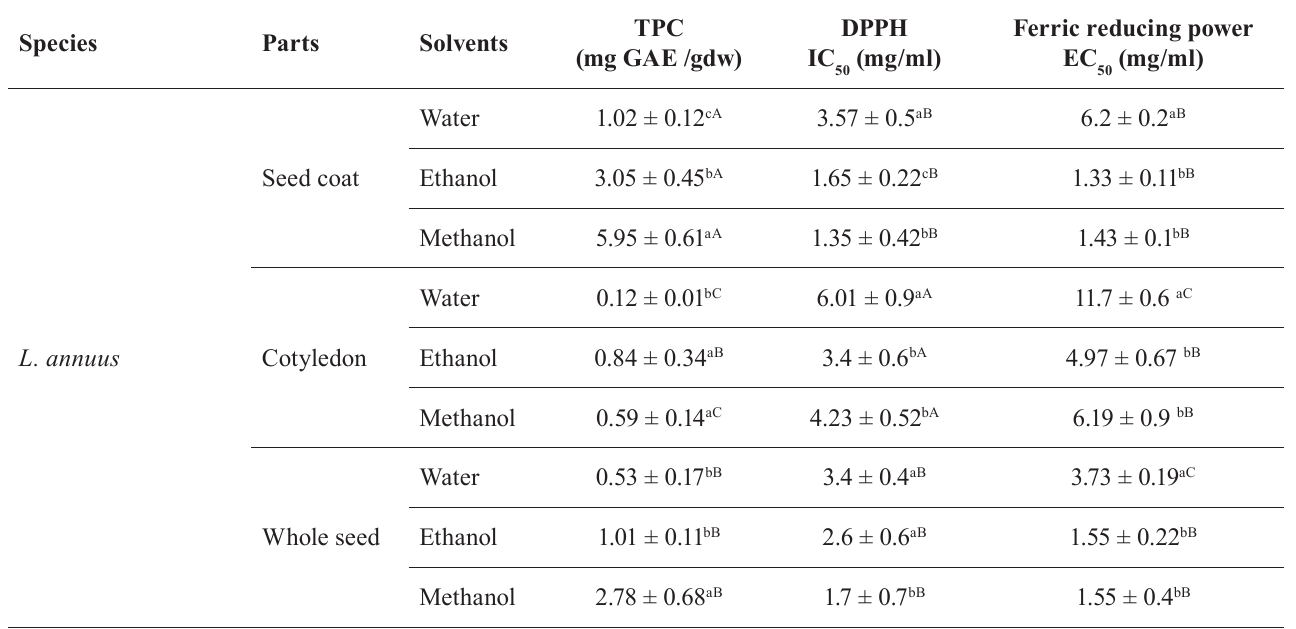
TABLE I - T otal phenolic content (TPC), DPPH radical scavenging activity (IC (EC ) values of extracts from Lathyrus seeds 50